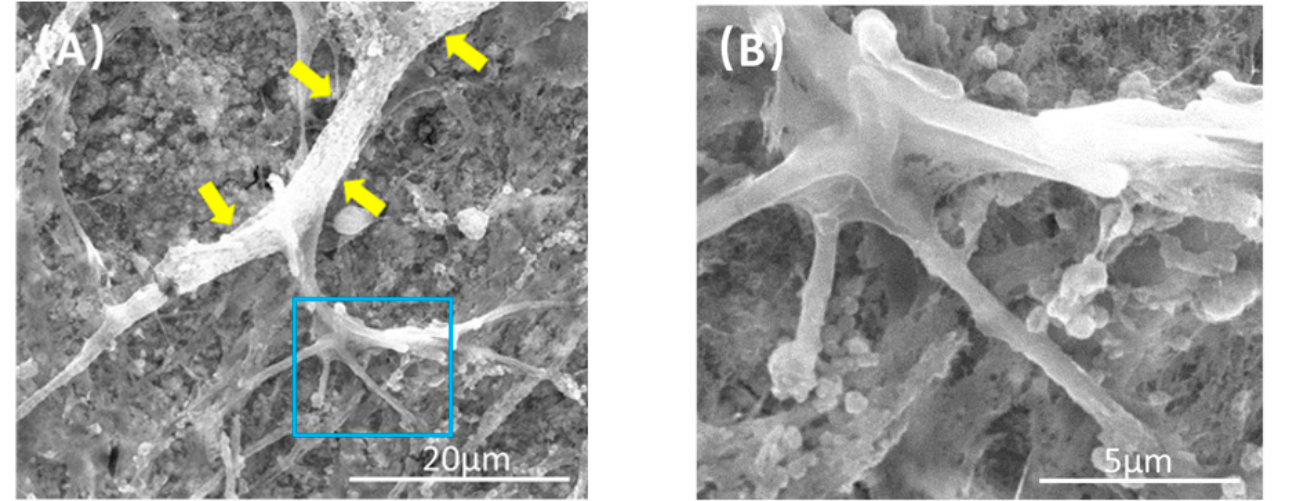
Figure 7. Representative SEM images of CPC scaffolds at 21 days. ( B ) is a higher magnification image of the blue dotted frame in ( A ). Capillary-like structures can be observed on the surface of CPC scaffolds (yellow arrows), and some branch-like stretches were found.